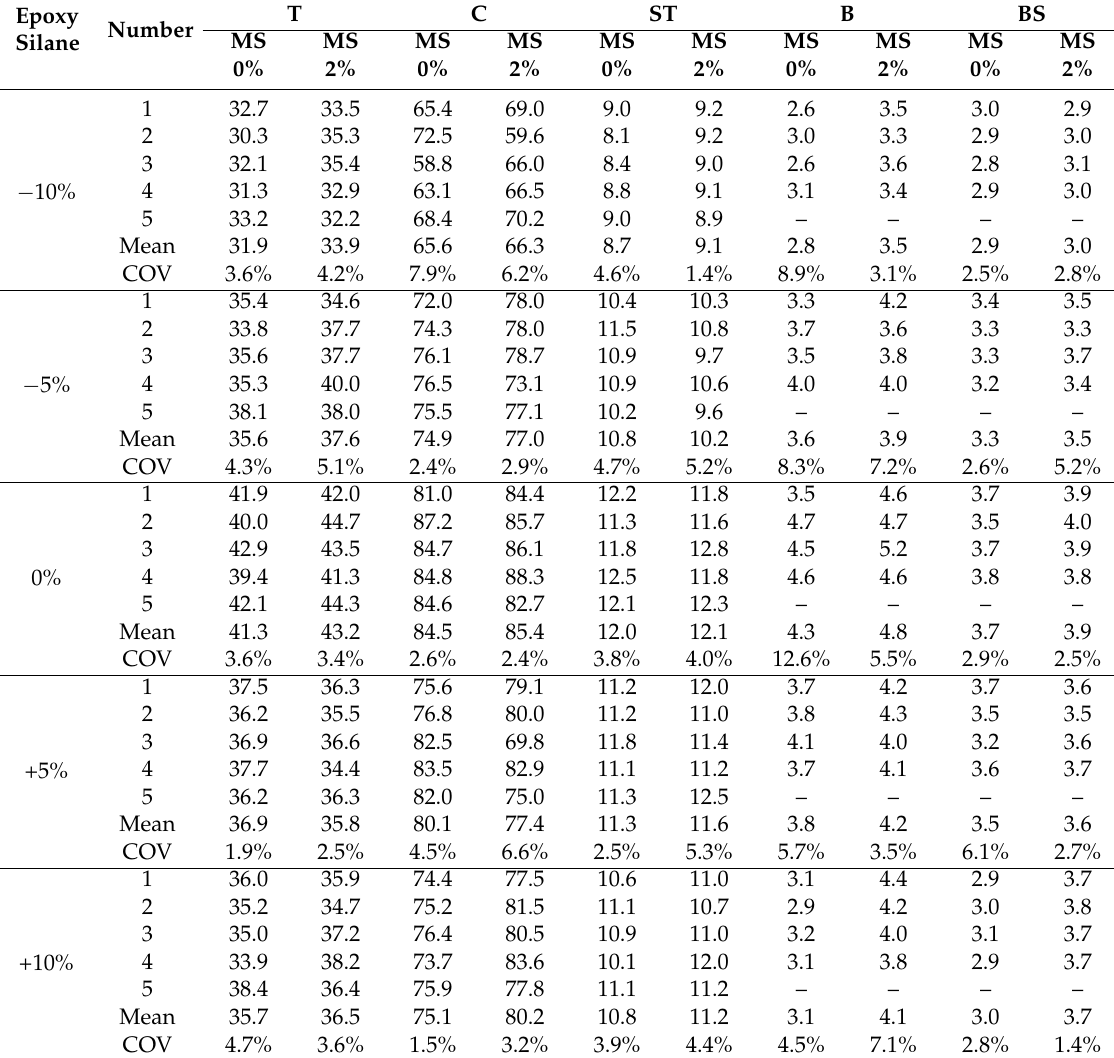
Table 5. Test results for mix ratio of epoxy silane and micro-silica (unit: